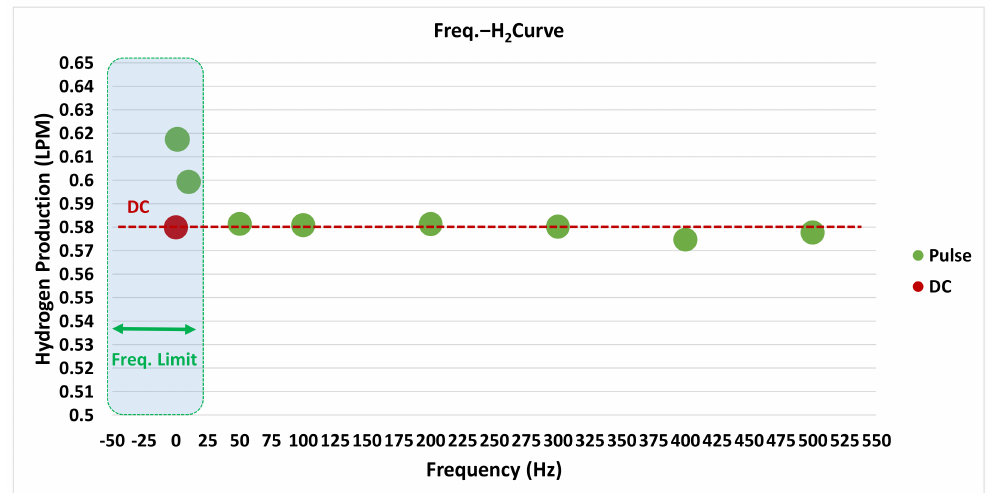
Figure 12. Frequency vs. H 2 characteristic curves of electrolyzer with pulse-frequency variable limits applied.